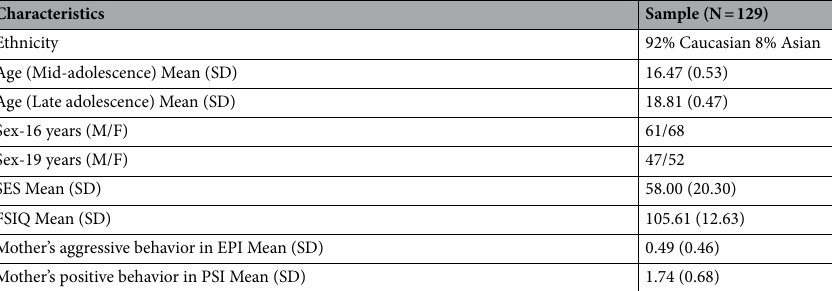
Table 1. Demographics and characteristics of the sample. Ethnicity was assessed based on genetics data for carrying the highest percentage of African, Asian or Caucasian alleles. SES: Socioeconomic Status, indicated by parental occupation status and assessed based on the Australian National University Four Scale 26 . FSIQ: Full- scale IQ test was assessed using a short form of the Wechsler Intelligence Scale for Children, 4th Ed. Maternal behavior was recorded in